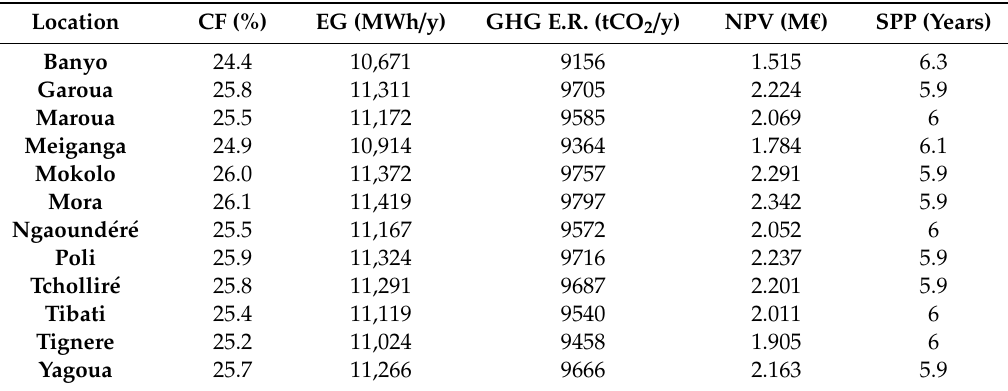
Table 10. RETScreen simulation results.